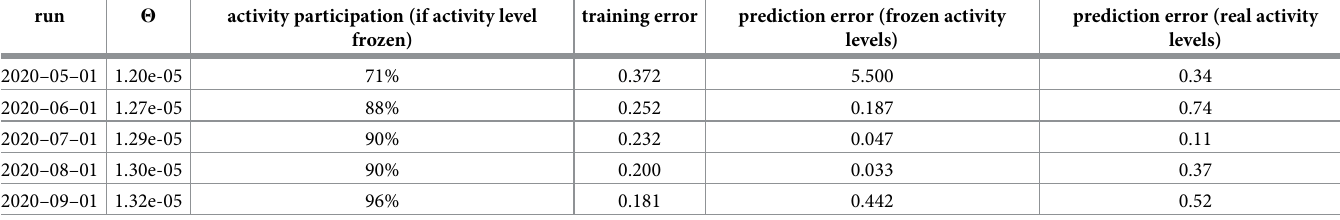
RMSLE (= Root Mean Square Logarithmic Error) for the calibration interval (training error) as well as for prediction period between 09–01 and 10–31 (prediction error). The Optuna package does not return confidence intervals for estimated